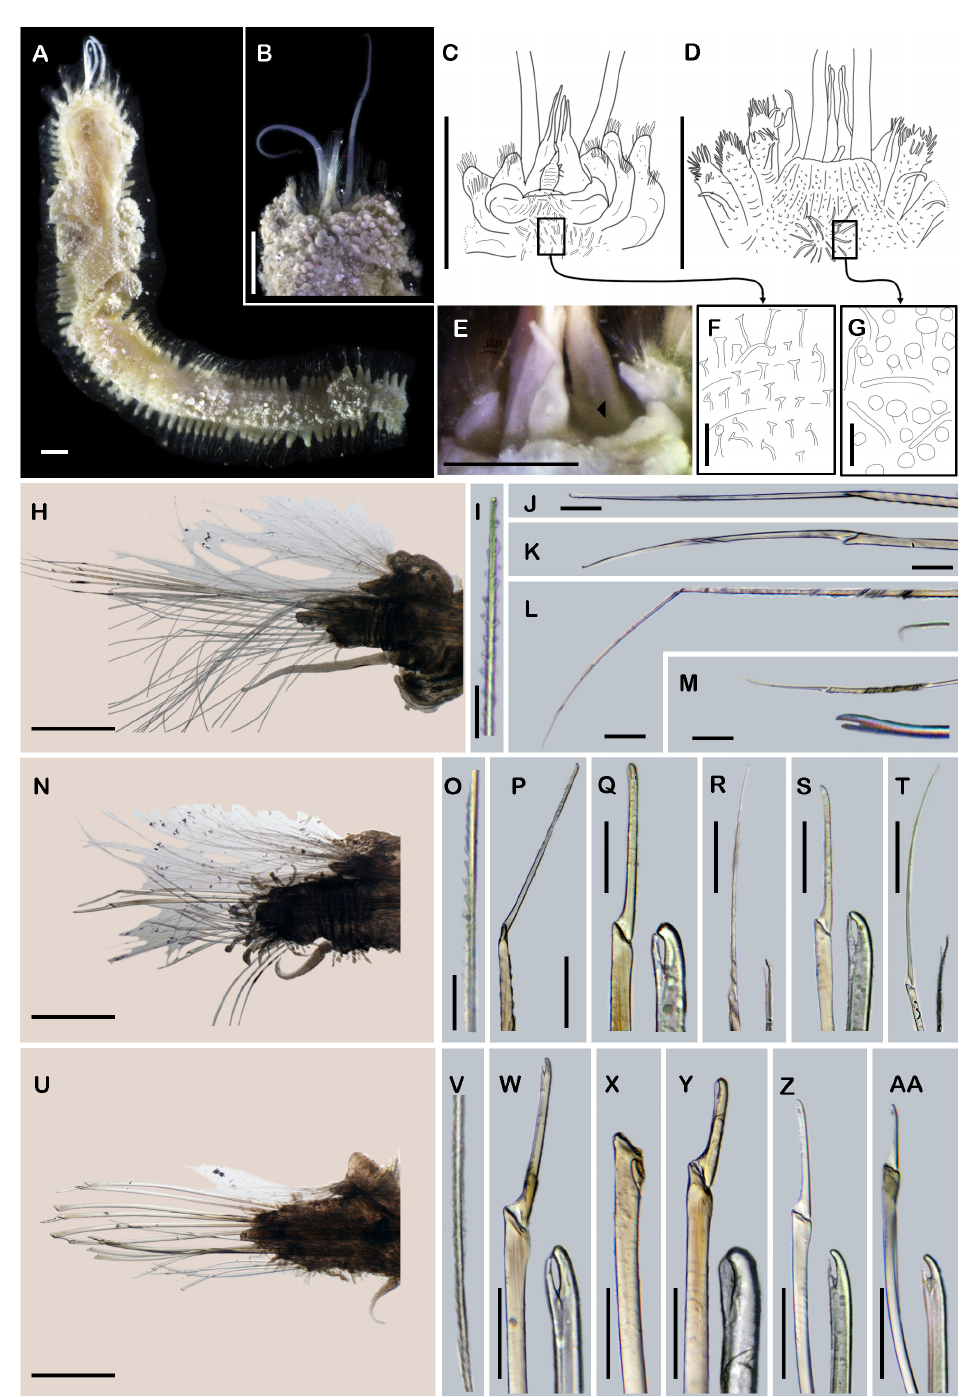
Fig. 9. Neopsammolyce fragilis sp. nov., holotype (UMML 22.1088). A . Incomplete worm, dorsal view. B . Anterior end, covered by elytra. C . Anterior end, dorsal view. D . Anterior end, ventral view. E . Detail of prostomium, arrowhead indicates lateral antenna. F . Dorsal papillae (close-up in box). G . Ventral papillae (close-up in box). H . Right parapodium from segment II. I . Notochaeta from same. J .